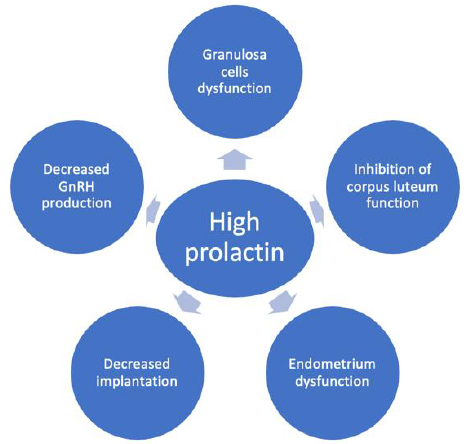
Figure 2. The mechanisms of reduced female fertility in hyperprolactinemia. Hyperprolactinemia may contribute to infertility by inducing decreased GnRH production, granulosa cell dysfunction, inhibition of corpus luteum function, endometrial dysfunction and decreased implantation.